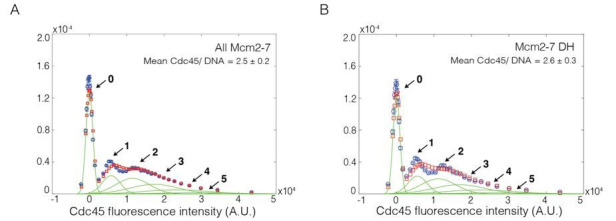
Cdc45 binding distribution is unchanged when using an Mcm2-7 double-hexamer (DH) selection.(A) Cdc45SORT649 fluorescence-intensity histograms for all detectable Mcm2-74SNAP549. (B) Cdc45SORT649 fluorescence-intensity histograms for only Mcm2-74SNAP549 DHs.